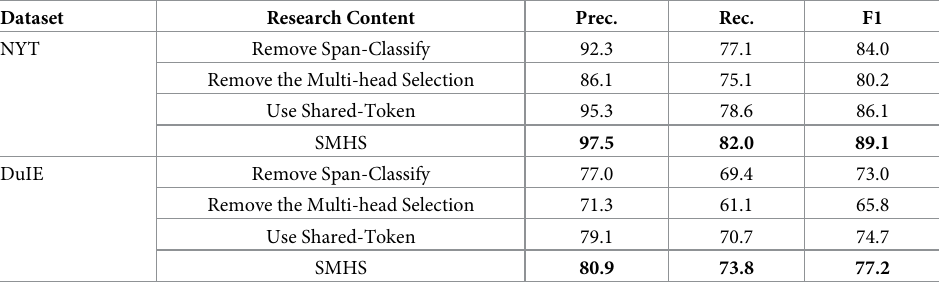
Table 7. Results of ablation experiments.